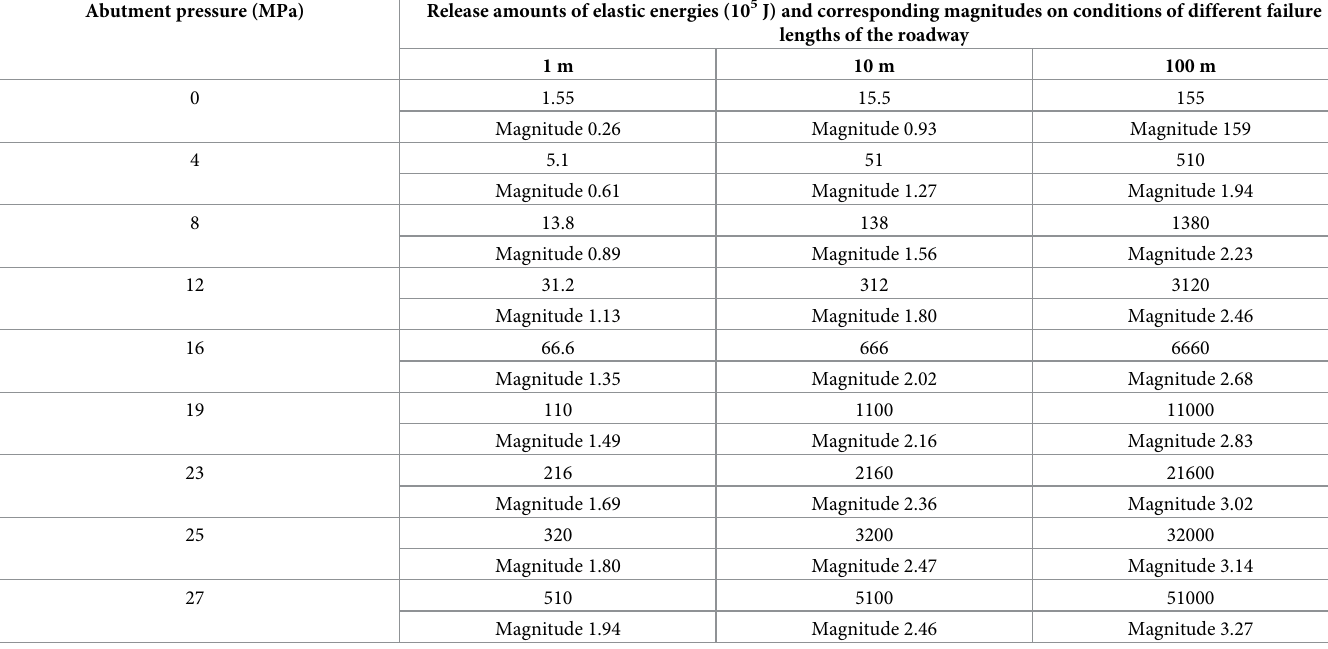
Table 2. Elastic energy released and corresponding magnitudes on conditions of different failure lengths of the roadway. Abutment pressure